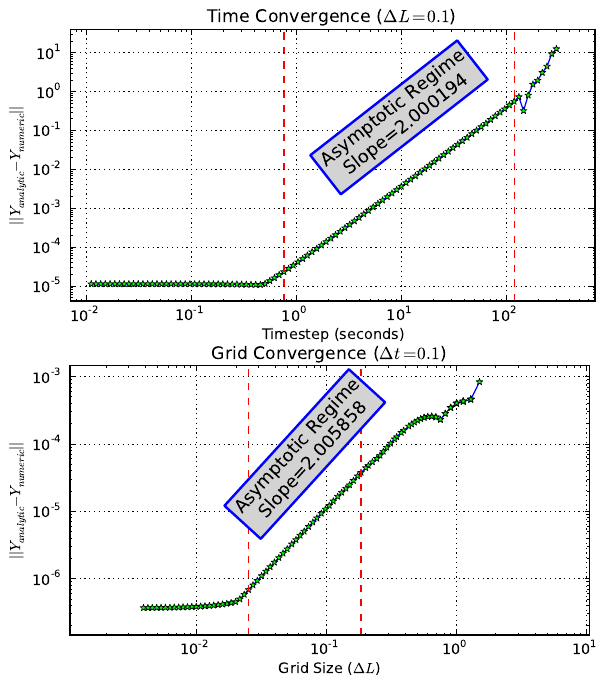
Fig. 5. Top frame (bottom frame): convergence as 1t ( 1L ) is re- fined. Each star represents the results from an individual simulation. The approximate location of the asymptotic regime is delimited by vertical red dashed lines. The slope of the line indicates the order of convergence; for each frame the correct, expected behavior is observed.